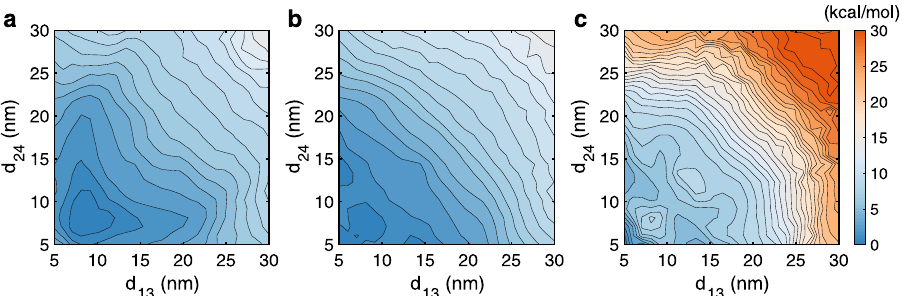
Fig. 5 Impact of speci fi c and non-speci fi c interactions on chromatin stability. a , b , c Contour of two dimensional free energy pro fi le as a function of the distance between 1 – 3 ( d 13 ) and 2 – 4 ( d 24 ) nucleosomes at 1 kcal/mol interval for the system without ( a ) and with ( b ) protein – protein interactions at 300 K and with protein – protein interactions at 250K ( c ).